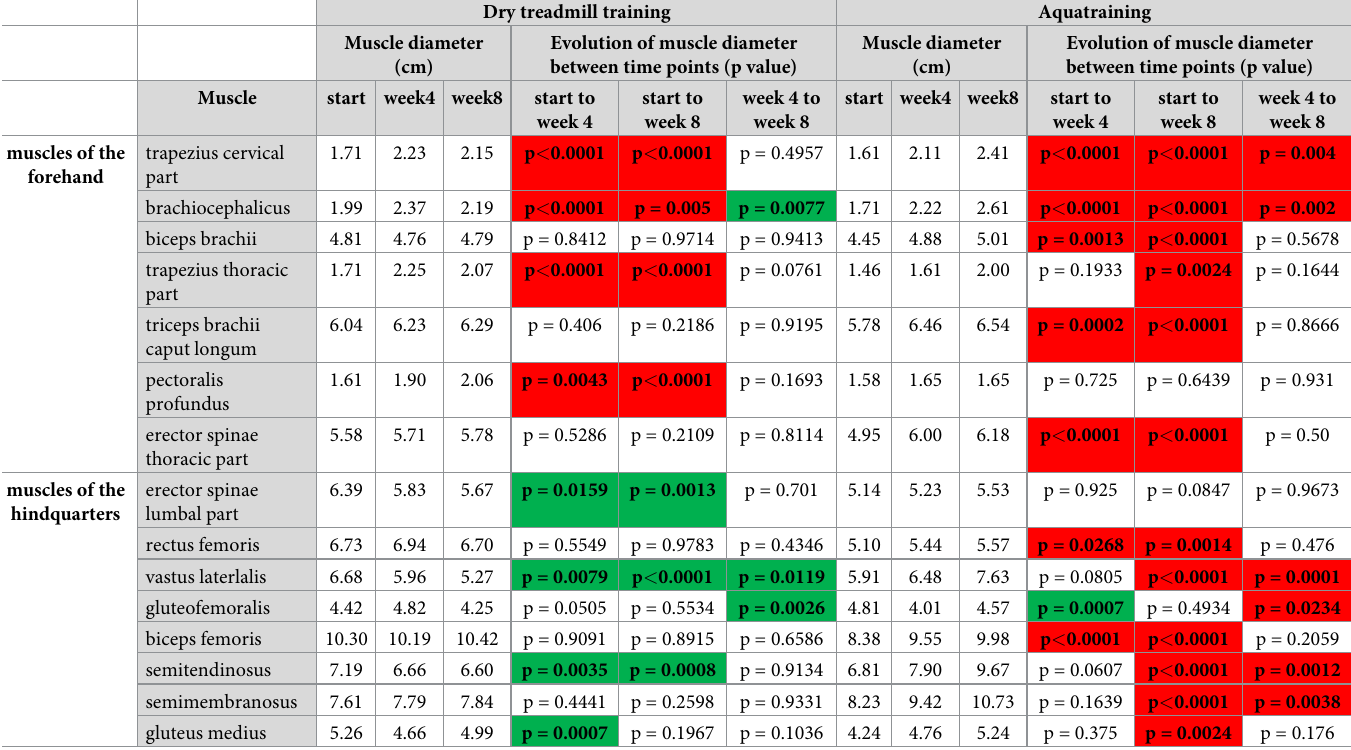
Table 1. Results of the muscle morphometric study. Evolution of muscle diameter after dry treadmill training and aquatraining. Dry treadmill training Aquatraining Muscle diameter Evolution of muscle diameter (cm) between time points (p value) Muscle muscles of the forehand biceps brachii